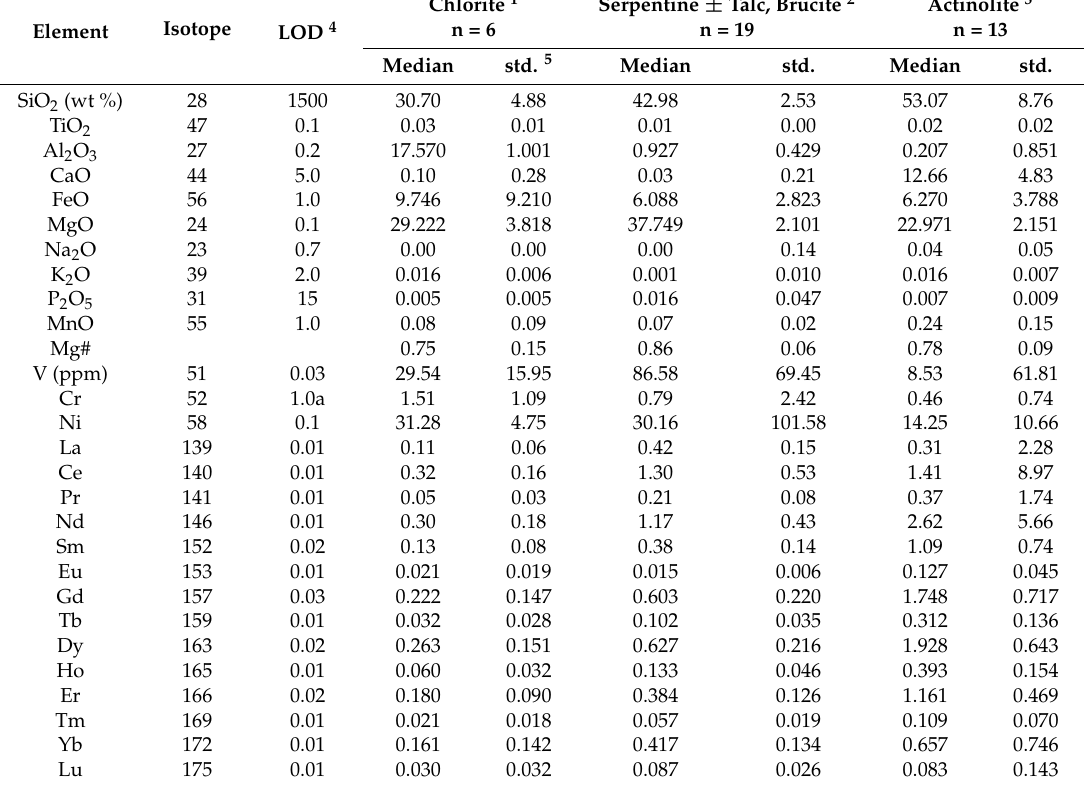
Table 3. Average chemical composition of silicates analyzed by LA-ICP-MS in LDC